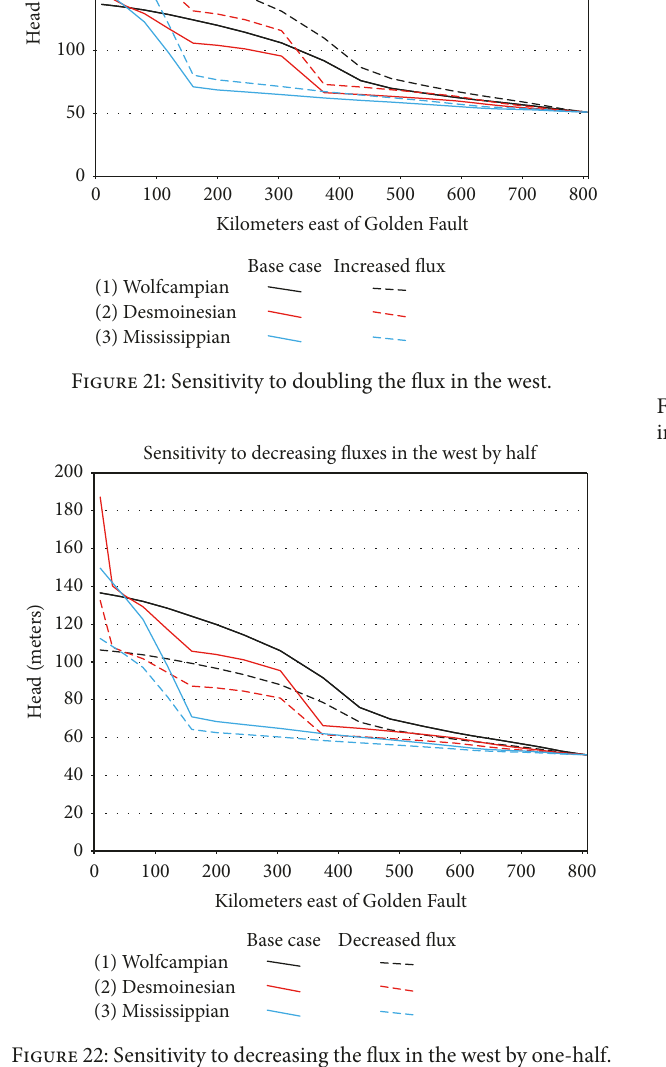
Figure 22: Sensitivity to decreasing the flux in the west by one-half.